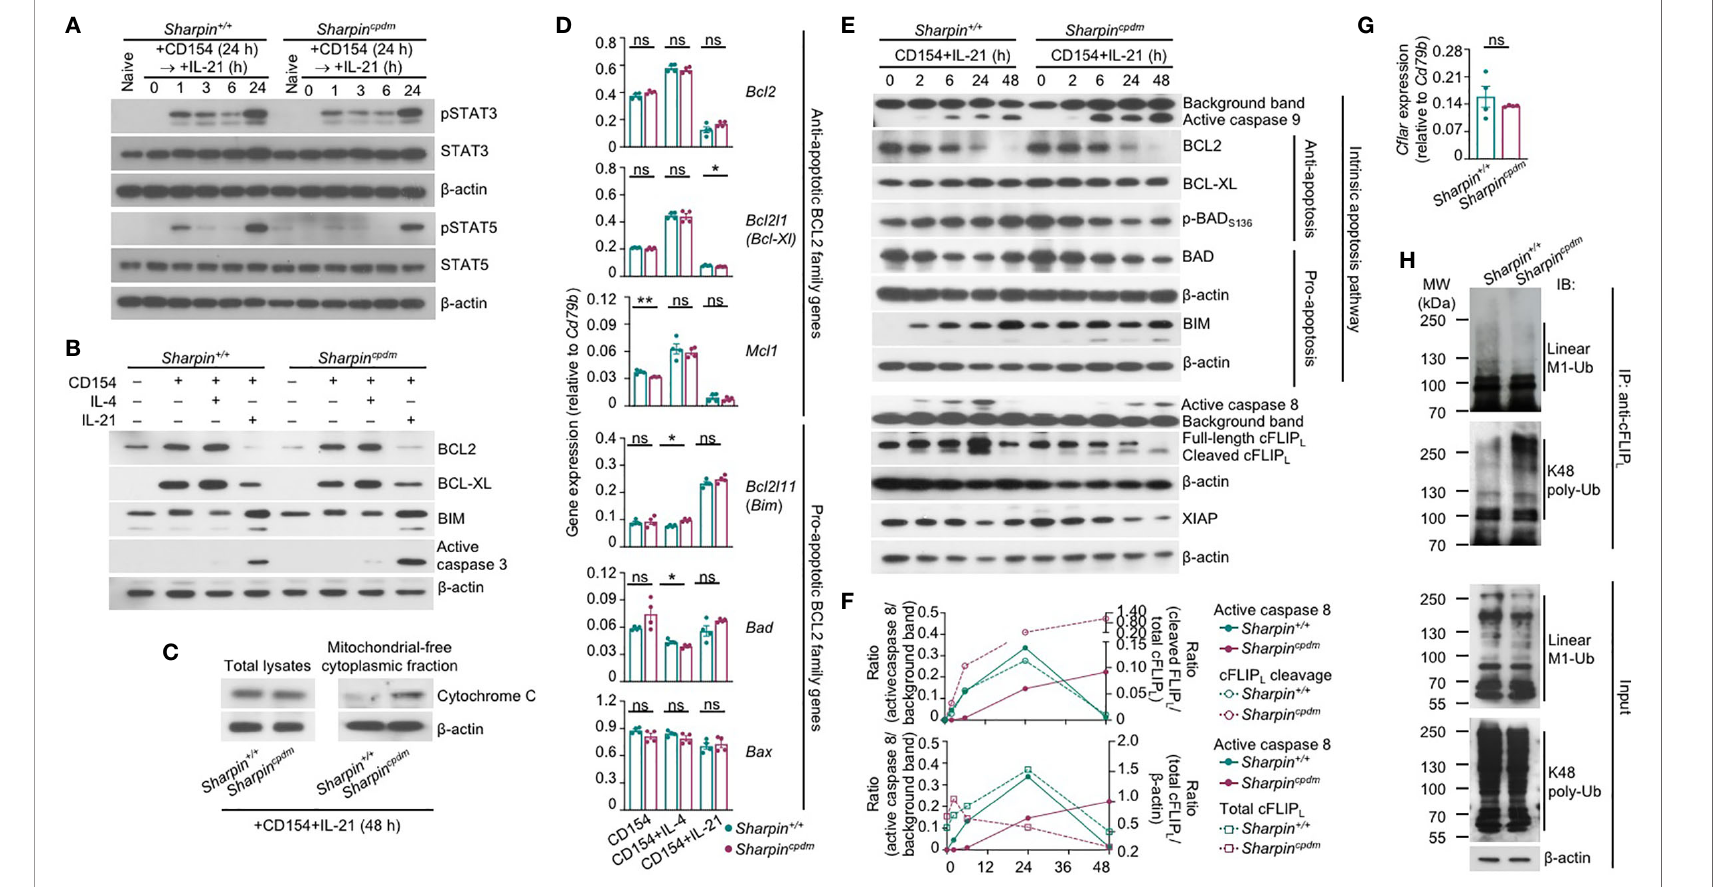
FIGURE 7 | SHARPIN inhibits caspase 8 and caspase 9 activation in B cells stimulated with CD154 and IL-21. (A) Immunoblotting analysis of STAT3 and STAT5 activation in Sharpin +/+ and Sharpin cpdm B cells stimulated with CD154 for 24 h and then IL-21 for different periods of time, as indicated. (B, C) Immunoblotting analysis of BCL2, BCL-XL and BIM expression and caspase 3 activation (B) and cytochrome C released into the cytosol (C) in Sharpin +/+ and Sharpin cpdm B cells stimulated for 48 h. (D) qRT-PCR analysis of gene expression, as indicated, in Sharpin +/+ and Sharpin cpdm B cells stimulated with CD154, alone or with IL-4 or IL-21, for 24 h (* p <0.05; ** p < 0.01; t-test). (E – F) Immunoblotting analysis of caspase 8 and caspase 9 activation, expression of cFLIP L , XIAP and BCL2 family members as well as BAD activation in Sharpin +/+ and Sharpin cpdm B cells stimulated with CD154 and IL-21 for different periods of time, as indicated. Quanti fi ed signals of caspase 8 activation, cFLIP L cleavage and total cFLIP L levels were depicted in (F) . (G) qRT-PCR analysis of C fl ar expression in Sharpin +/+ and Sharpin cpdm B cells stimulated with CD154 plus IL-21 for 24 h (t-test). (H) Proteins in whole cell lysates (input) and immunoprecipitated by anti-cFLIP were analyzed by immunoblotting for linear M1-Ub and K48 poly-Ub levels in Sharpin +/+ and Sharpin cpdm B cells stimulated with CD154 plus IL-21 for 48 h. All immunoblotting analyses were representative of two independent